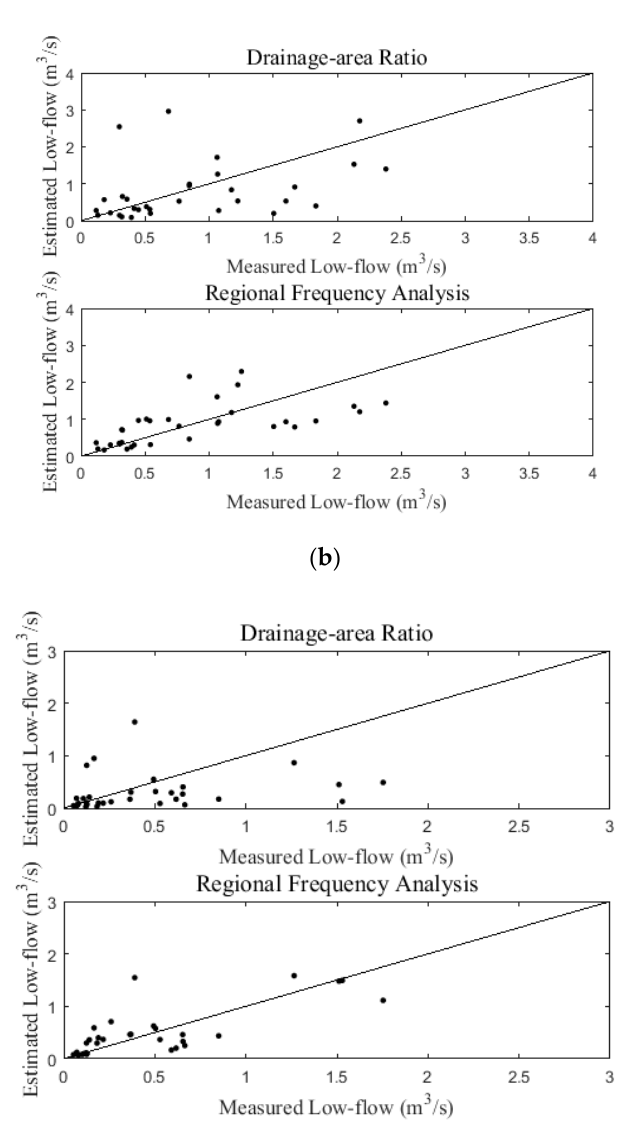
Figure 7. Plot of the estimated flow and measured flow based on the drainage-area ratio for Misung station and regional frequency analysis for the ( a ) two-year low-flow quantile and ( b ) five-year low-flow quantile derived from the Gamma distribution.